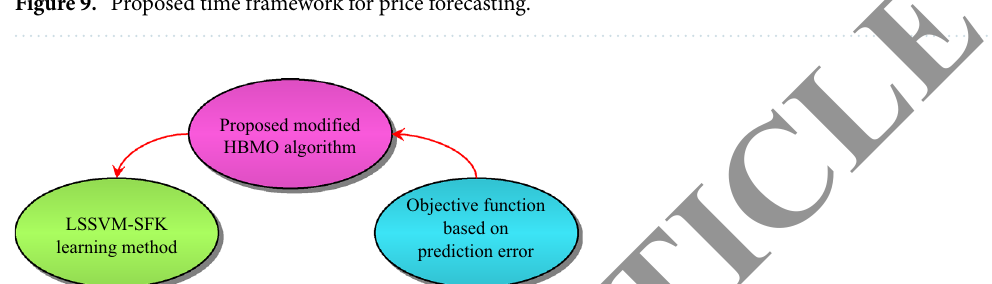
Figure 10. A typical overview of relation between HBMO and learning method in order to decreases the prediction